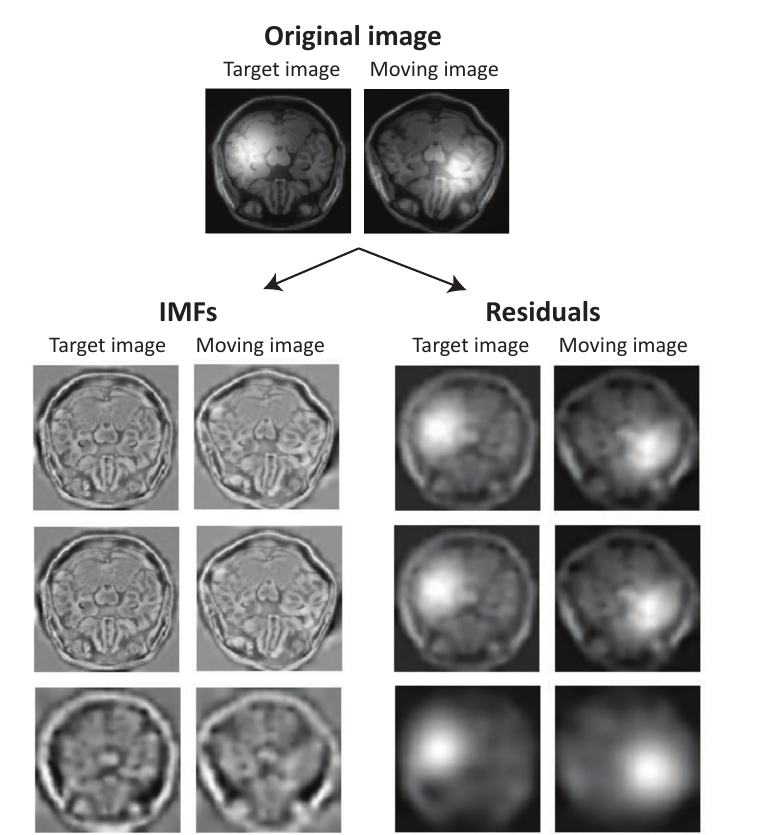
Figure 2. EMD separates bias field noise from the intrinsic components. The set of IMFs and residuals for three levels of EMD are shown for both floating and reference images. The Gaussian function is explained in the residuals and IMFs are noise